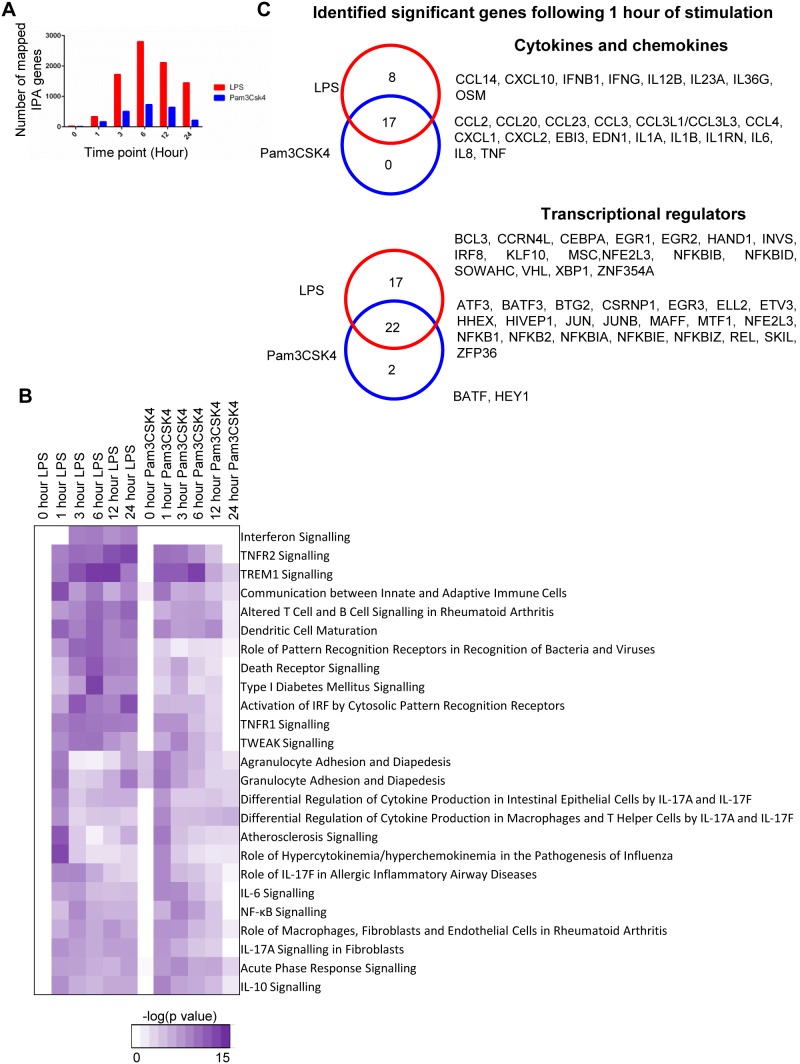
Transcript lists analysed at each time point.(A) A graph showing the number of genes from the respective significant transcript lists (4777 LPS and 1202 Pam3CSK4 lists) at each time point which are more than 1.8 FC different compared to the media control at that time point. (B) The significantly expressed transcript lists (1202 Pam3CSK4 transcript list and 4777 LPS transcript list) were analysed in IPA. For each time point only genes whose expression were 1.8 FC different from the media control at that time point were taken into consideration. Shown is a heatmap of pathway significance of the top 25 IPA canonical pathways for each time point where significance criteria met (Fishers Exact test p<0.01). The IPA canonical pathways were chosen by identifying from the LPS stimulation analyses the top 25 most significant pathways across the time points (mean –log p value) and then compared to Pam3CSK4. (C) Venn diagrams of cytokine/chemokines and transcriptional regulators identified using IPA gene functional classification from LPS 4777 and Pam3CSK4 1202 transcript lists with mean expression greater than 1.8 FC different to media control at 1 hour. Listed adjacent to the Venn diagrams are the genes from each subset.